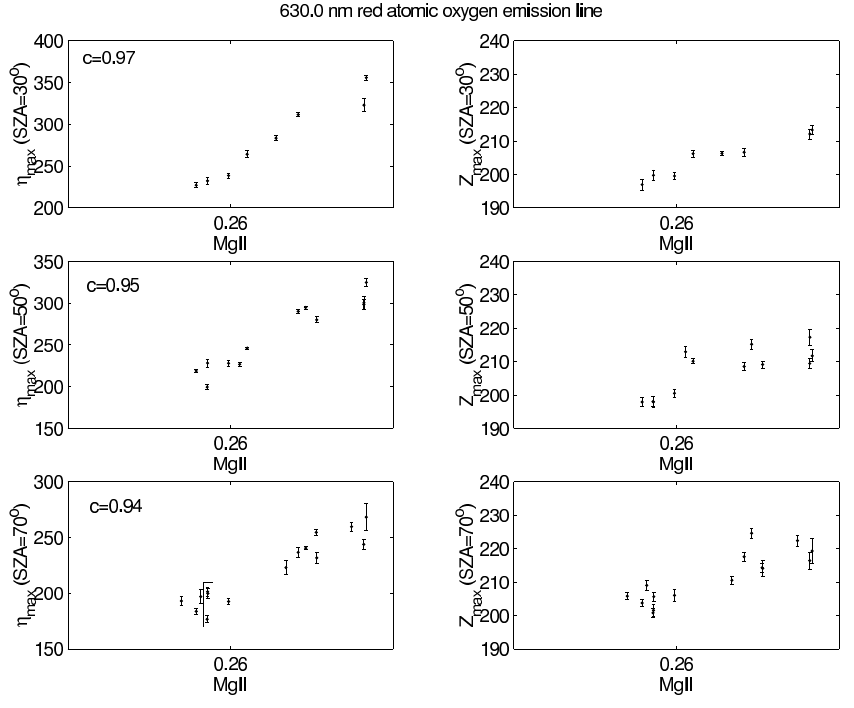
Fig. 12. WINDII measurements of the 630.0nm volume emission rates and maximum emission altitudes for quiet geomagnetic days ( A p ≤ 10), from 1992 to 1995. Data are plotted versus the MgII index, and error bars correspond to the standard